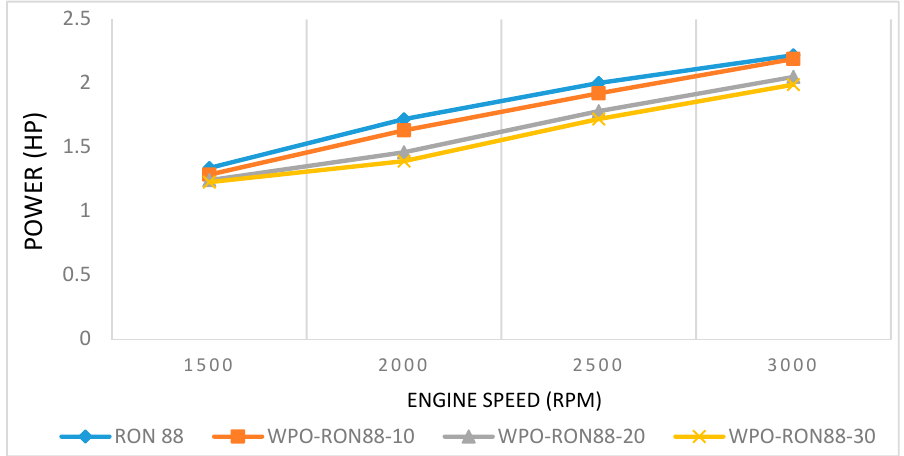
Figure 5. Effect of WPO-RON88 blends on engine power compared to RON88. Figure 5. E ff ect of WPO-RON88 blends on engine power compared to